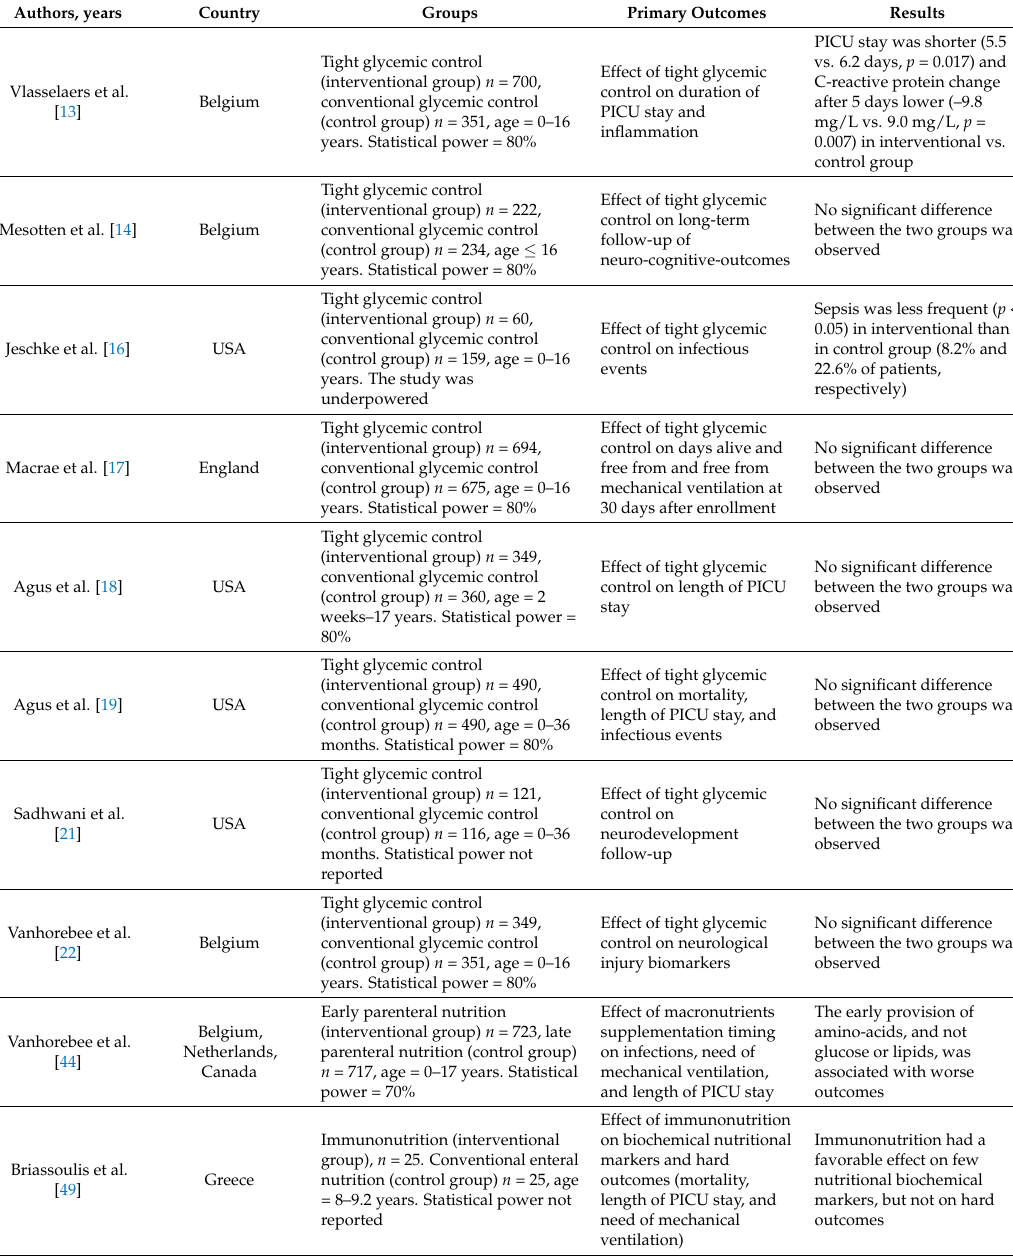
Table 1. Randomized clinical trials on glycemic control and nutrition in critically-ill